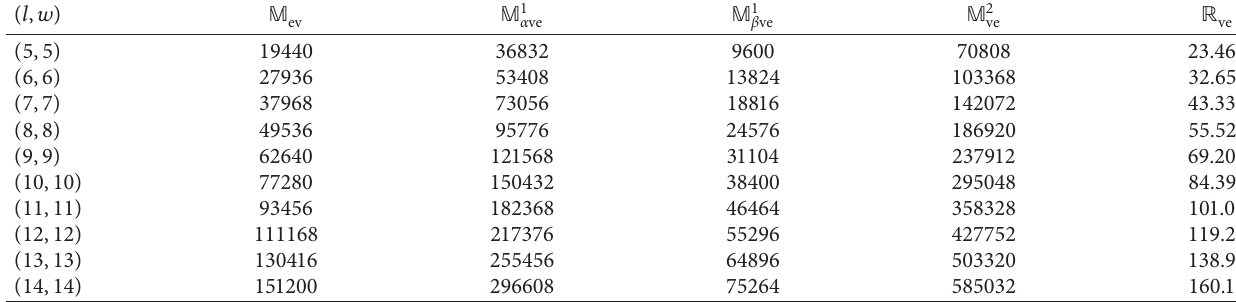
Table 4: Numerical representation of results.